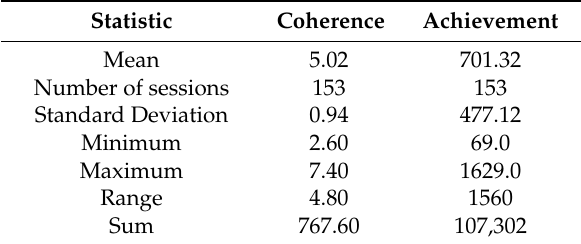
Table 1. Descriptive Statistics for Inner Balance Coherence and Achievement scores.